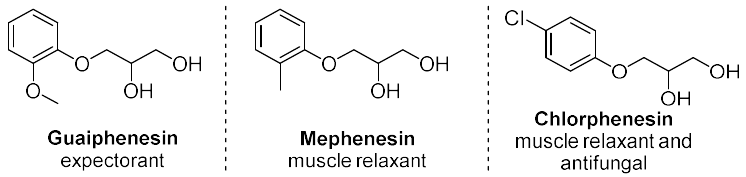
Figure 5. Structure of pharmaceutically important products.